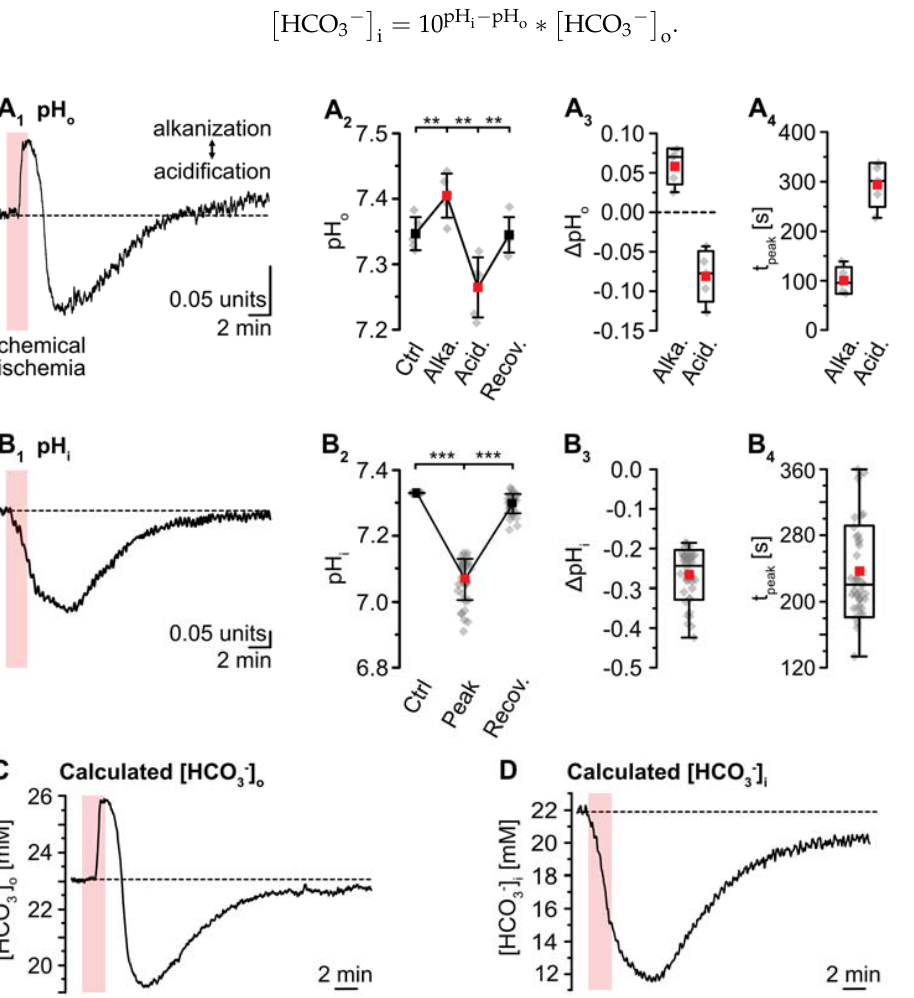
Figure 5. Ischemia-induced changes in pH and [HCO 3 − ]. ( A ) pH o . ( A 1 ): Biphasic change in pH o in an individual experiment. ( A 2 ): Plot illustrating baseline pH o , peak alkalinization, acidification, and subsequent recovery of pH o . Shown are individual data points (grey diamonds), means (squares), and SDs (whiskers). ( A 3 , A 4 ): Box plots illustrating peak changes in pH o ( A 3 ) as well as the time-to-peak ( A 4 ). ( B ) Same illustration as in ( A ) for changes in astrocytic pH i . ( B 1 ): Individual measurement. ( B 2 ): Plot illustrating baseline pH i , peak changes, and its subsequent recovery. ( B 3 , B 4 ): Box plots of peak changes in pH i ( B 3 ) and the time-to-peak ( B 4 ). Box plots in ( A 3 , A 4 ) and ( B 3 , B 4 ) show individual data points (grey diamonds), means (squares), medians (horizontal lines), SDs (boxes), and min/max (whiskers). ( C , D ) Calculated change in [HCO 3 − ] o and [HCO 3 − ] i , as derived from the Henderson–Hasselbalch equation and Equation (5), respectively. ( A 2 , B 2 ): ** p < 0.005, *** p < 0.0005 (Šidák corrected significance levels).